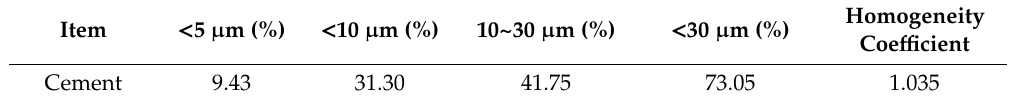
Table 1. Particle size distribution of cement.